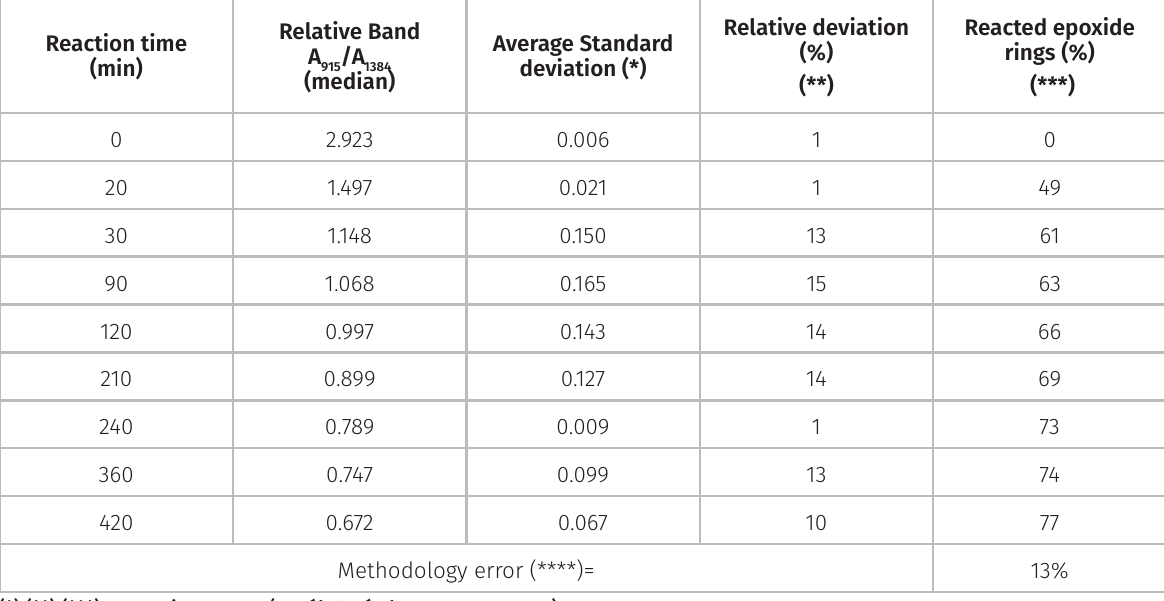
Table II. Resumed MIR/transmission (A Reaction time (min)